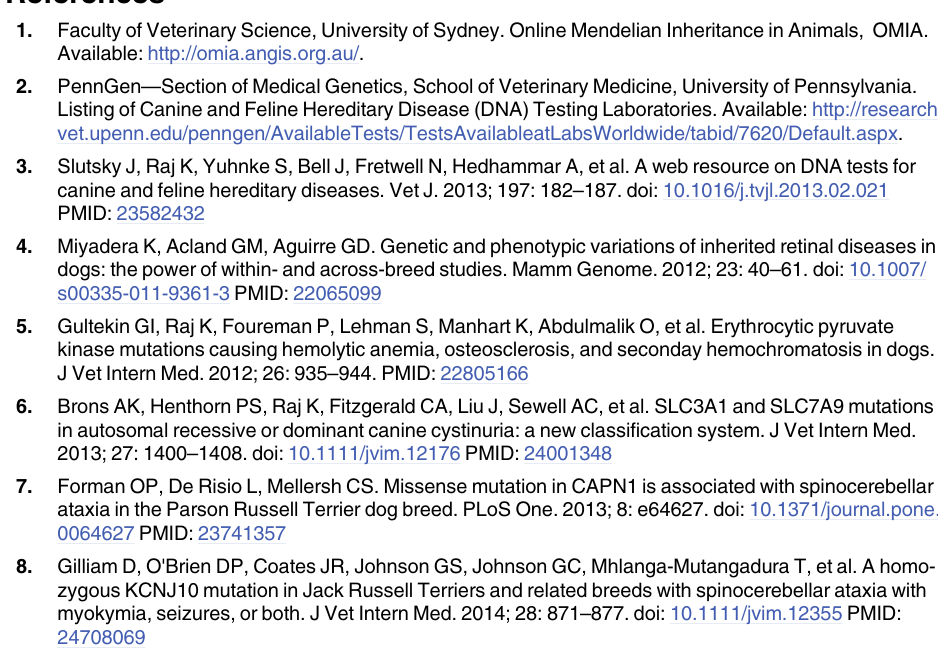
S1 Table. Number of studied dogs by breed. S2 Table. Disease variants screened in the study. S3 Table. Sequencing